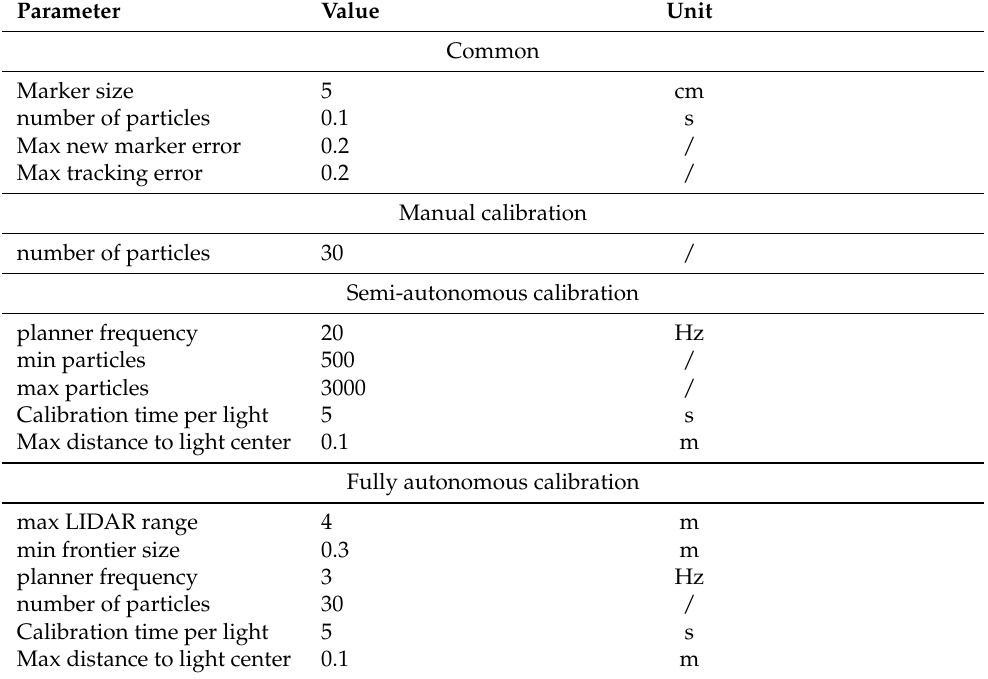
Table 1. Main calibration